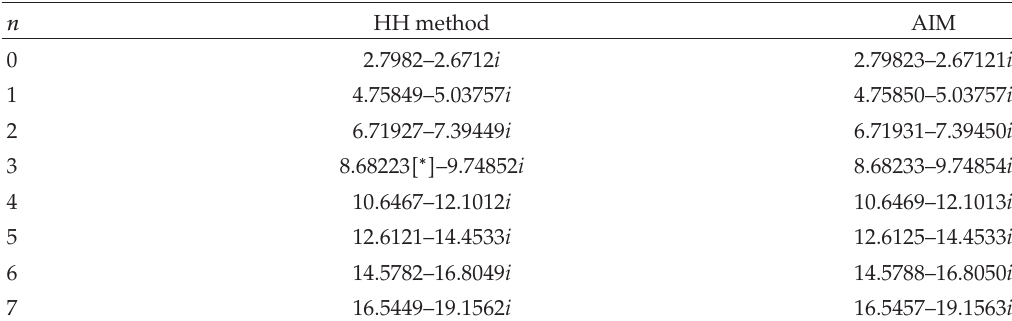
Table 3: Comparison of the first few QNMs to 6 significant figures for Schwarzschild anti-de-Sitter scalar perturbations (cid:2) s (cid:8) 0 (cid:3) for (cid:12) (cid:8) 0 modes with r (cid:9) (cid:8) 1. The second column corresponds to data (cid:5) 40 (cid:6) using the Horowitz and Hubeny (cid:2) HH (cid:3) method (cid:5) 38 (cid:6) , while the third column is for the AIM using 70 iterations. (cid:5) ∗ (cid:6) Note the mismatch for the real part of the n (cid:8) 3 mode in (cid:5) 40 (cid:6) ; we have confirmed this using the Mathematica notebook provided in (cid:5) 24 (cid:6)